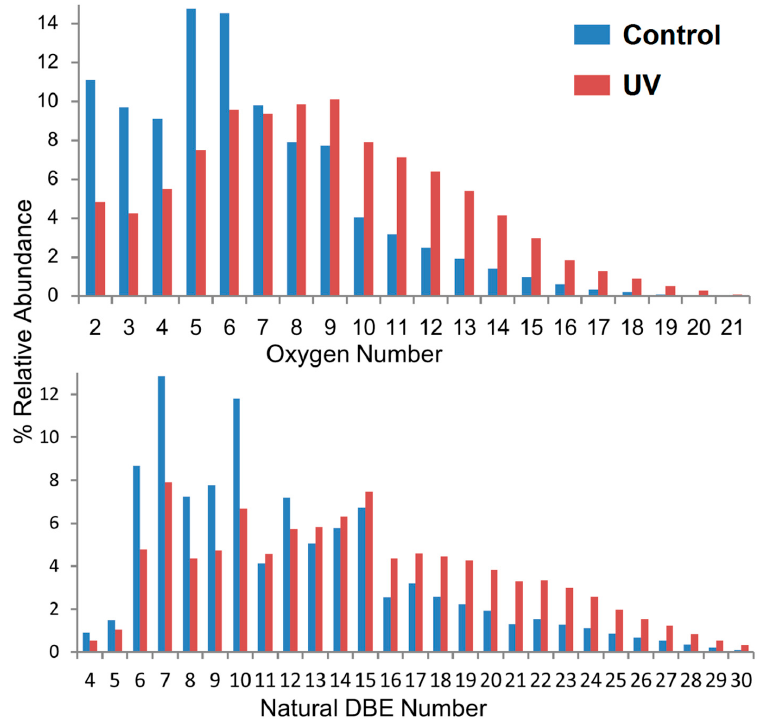
Figure 9. Relative abundances of oxygen-containing compounds (top) and double-bond equivalent (DBE) distribution (bottom) of lignins in control and oxidized samples. The relative abundance is the individual compound mass spectral peak abundance divided by the summed magnitudes of all peaks in the spectrum. Reprinted from Qi et al., with permission from Springer Publishing [32]. Molecules 2020 , 25 , x FOR PEER REVIEW